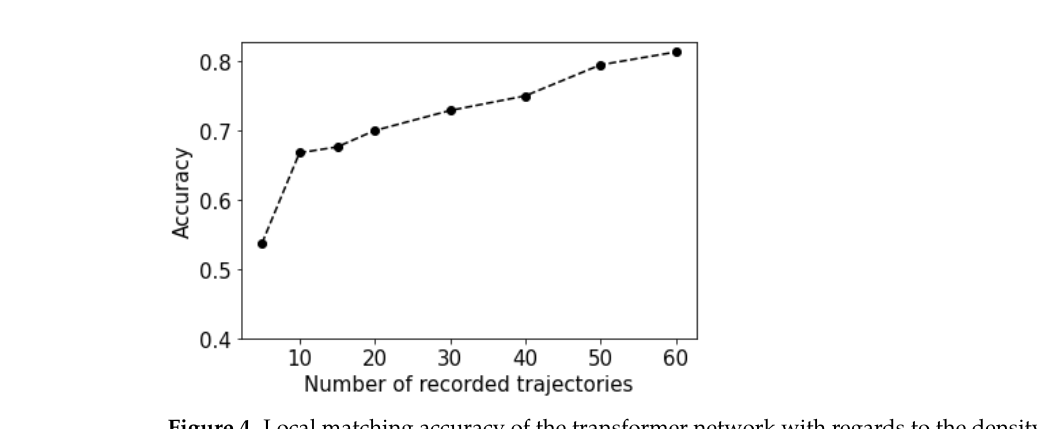
Figure 4. Local matching accuracy of the transformer network with regards to the density of trajectories of a given area. Table 2. Comparison of the matching accuracy with regards to the geometry of road segment.